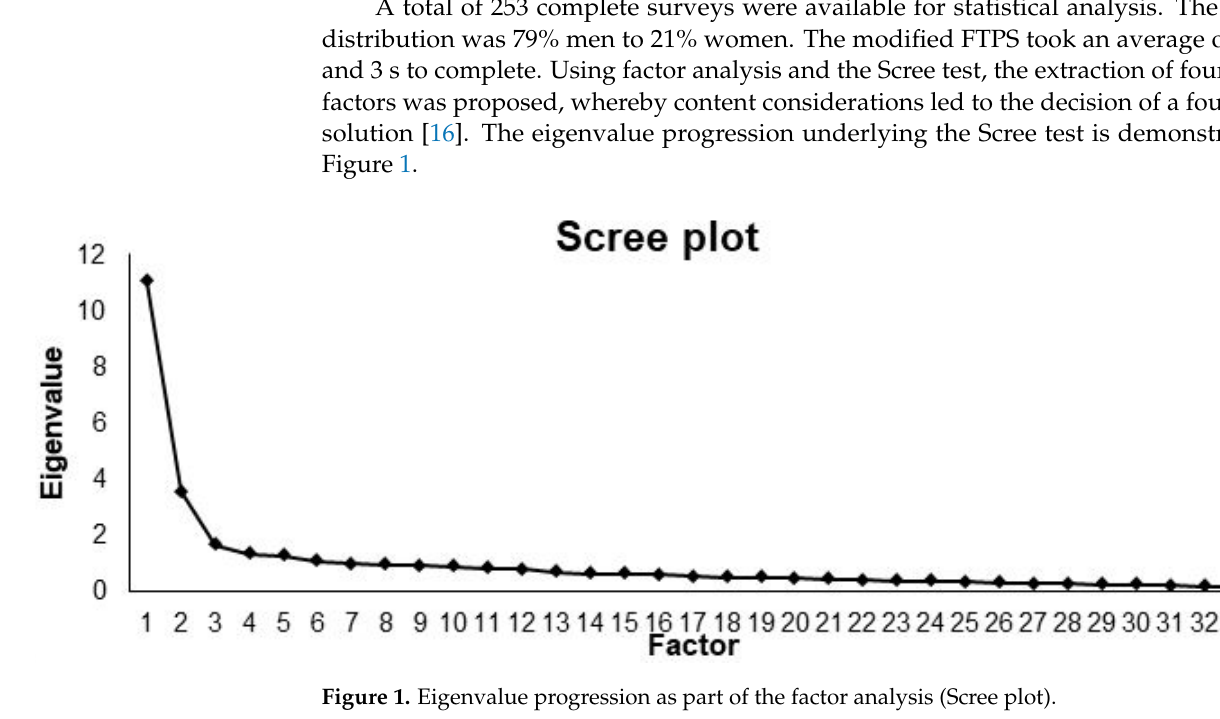
Figure 1. Eigenvalue progression as part of the factor analysis (Scree plot).